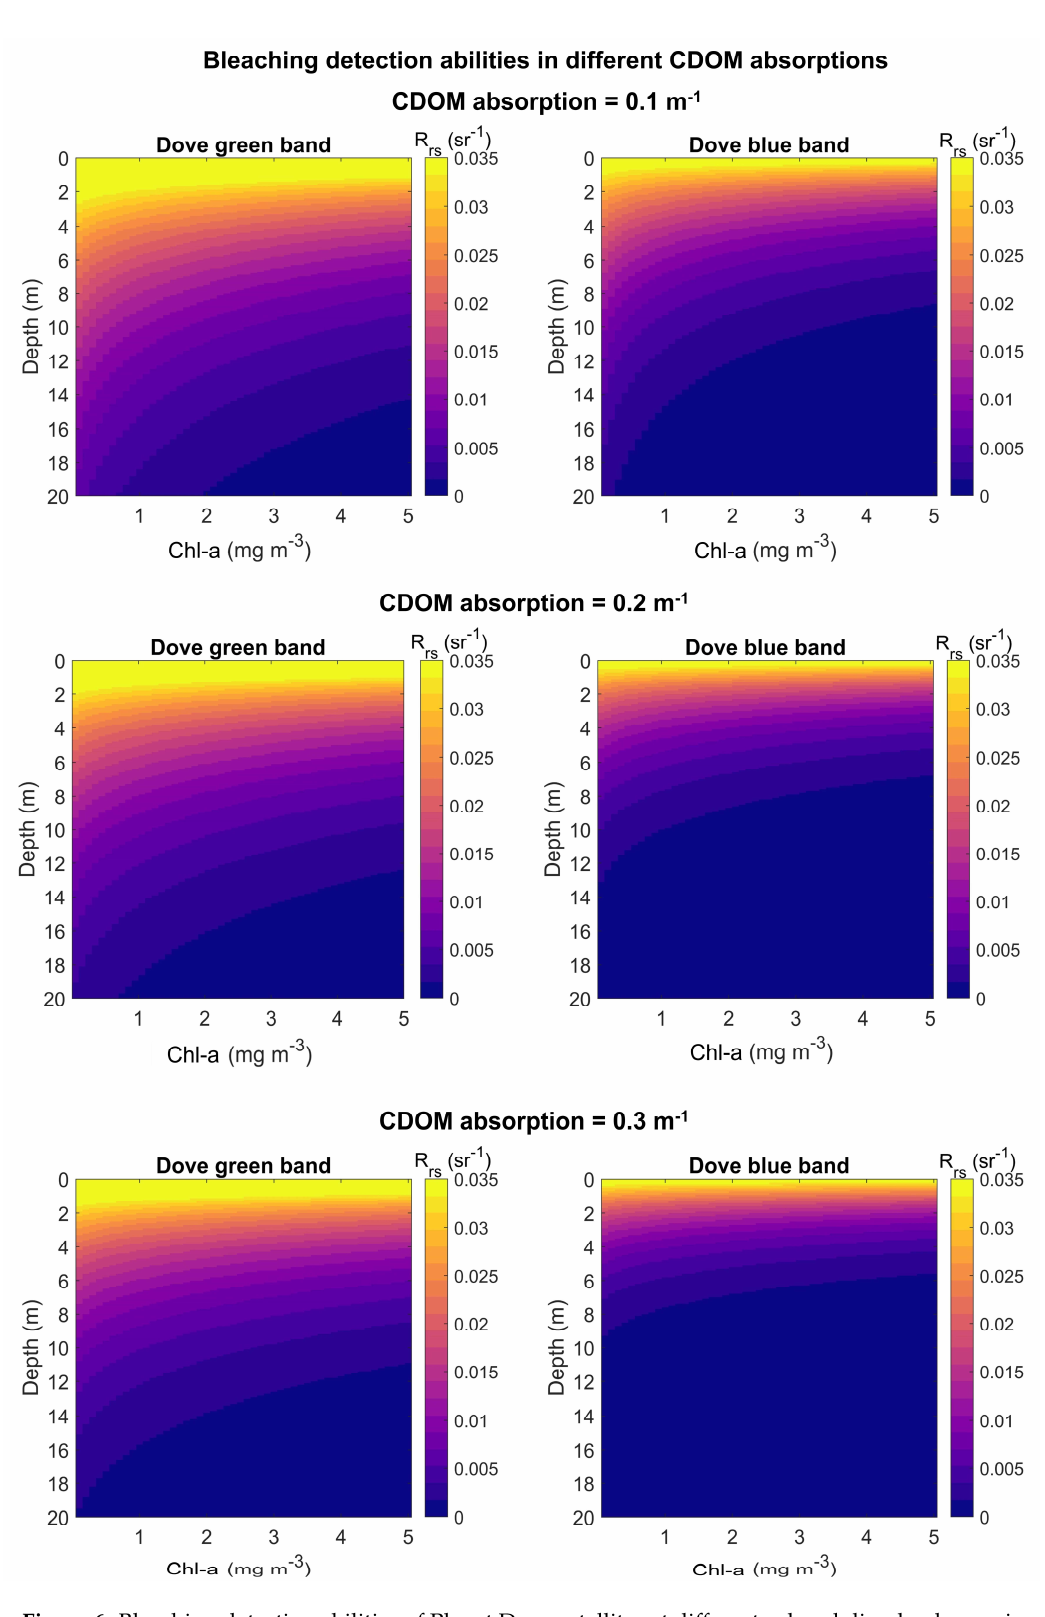
Figure 6. Bleaching detection abilities of Planet Dove satellites at different colored dissolved organic matter (CDOM) absorptions.